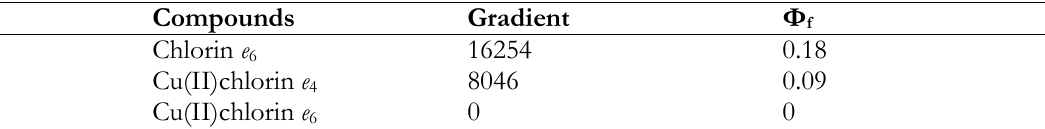
Tabel III. Singlet oxygen quantum yields of Cu(II)chlorin e 4 and Cu(II)chlorin e